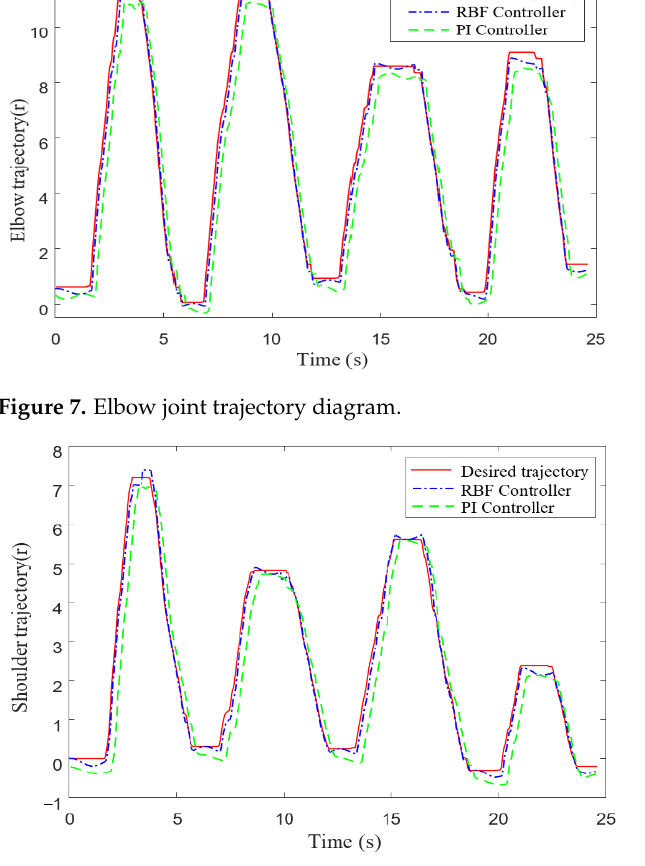
Figure 8. Shoulder joint trajectory diagram.